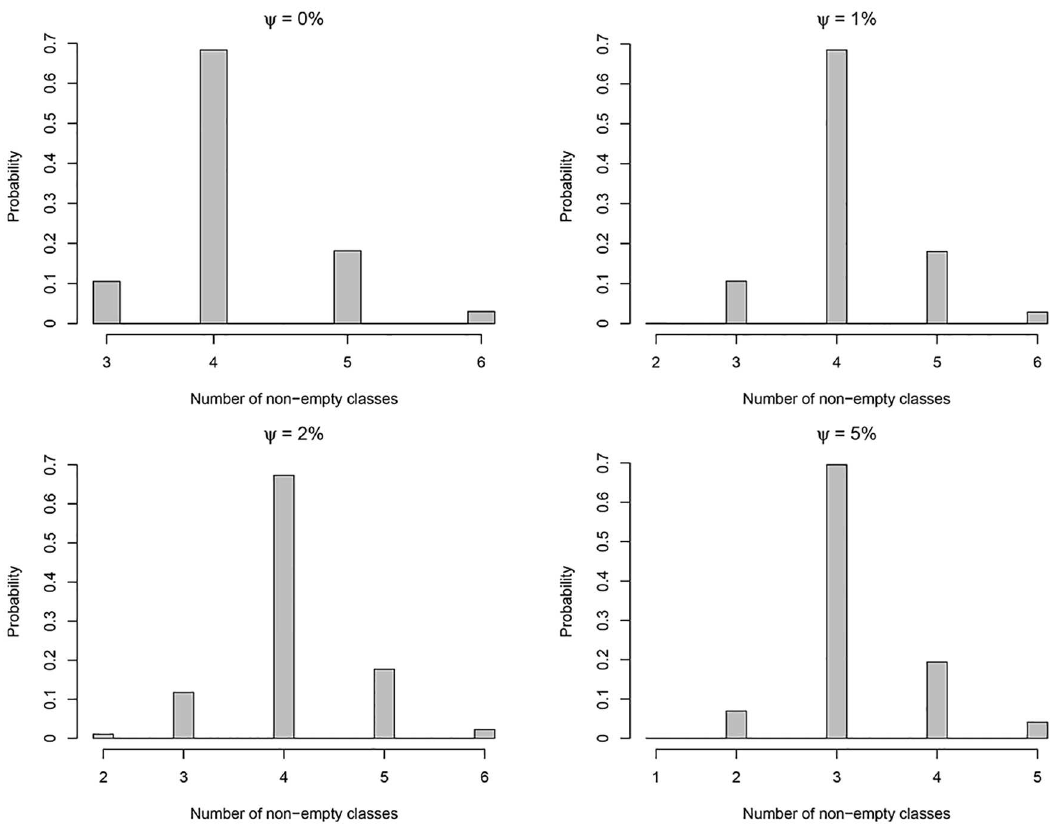
Fig 4. Posterior distribution of non-empty classes(K) for different cut-offs ( ψ